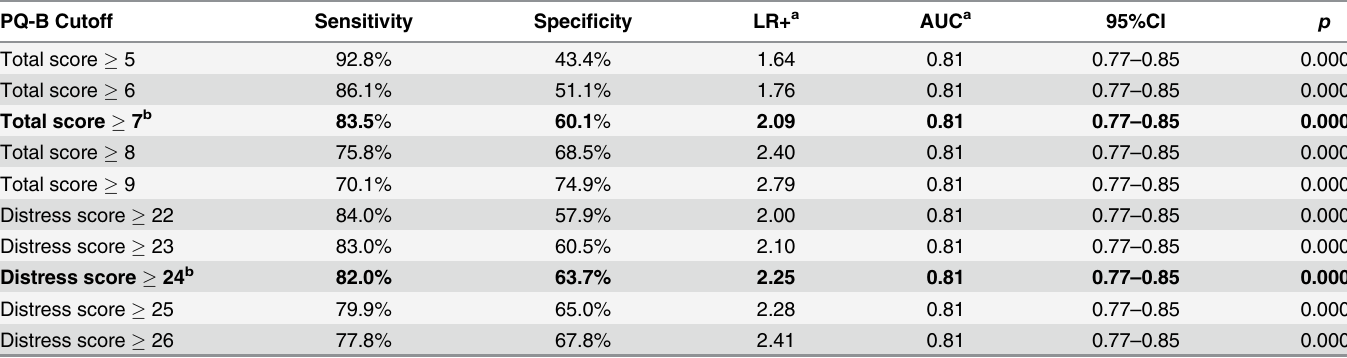
Table 3. Sensitivity, specificity, and AUC at various cutoff points of PQ-B scores. PQ-B Cutoff